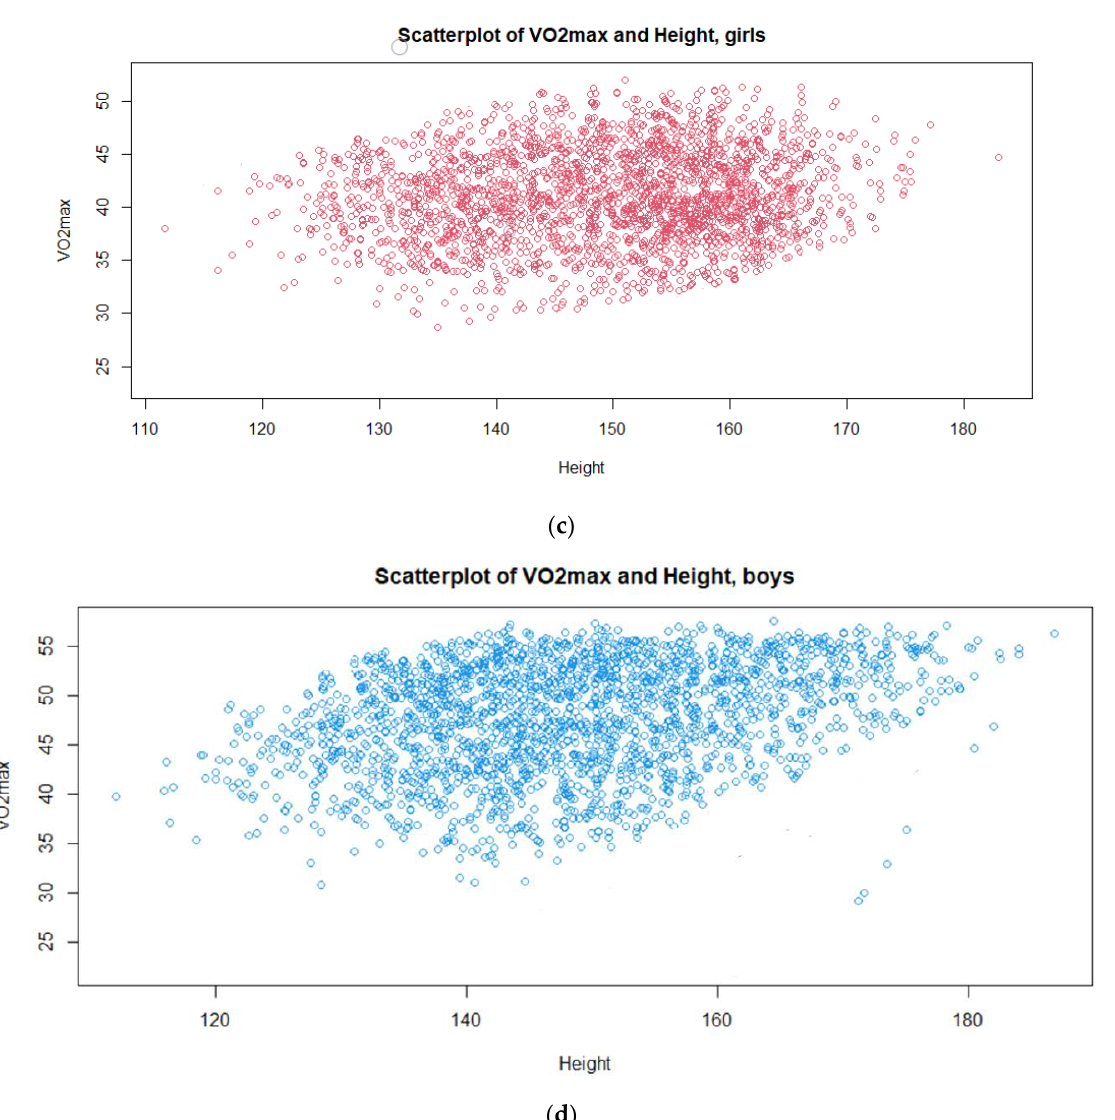
Table 4. Performance evaluation by method.